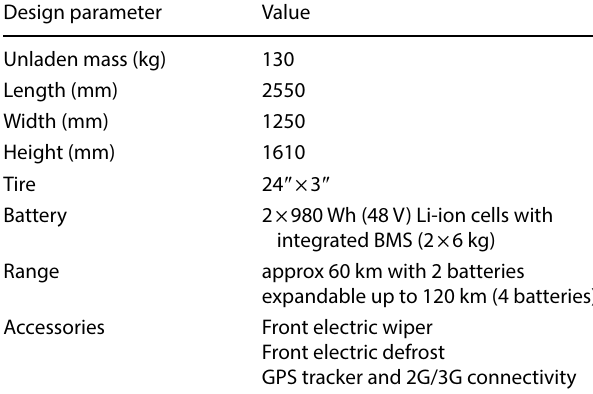
Table 1 SNAP main technical specifications Design